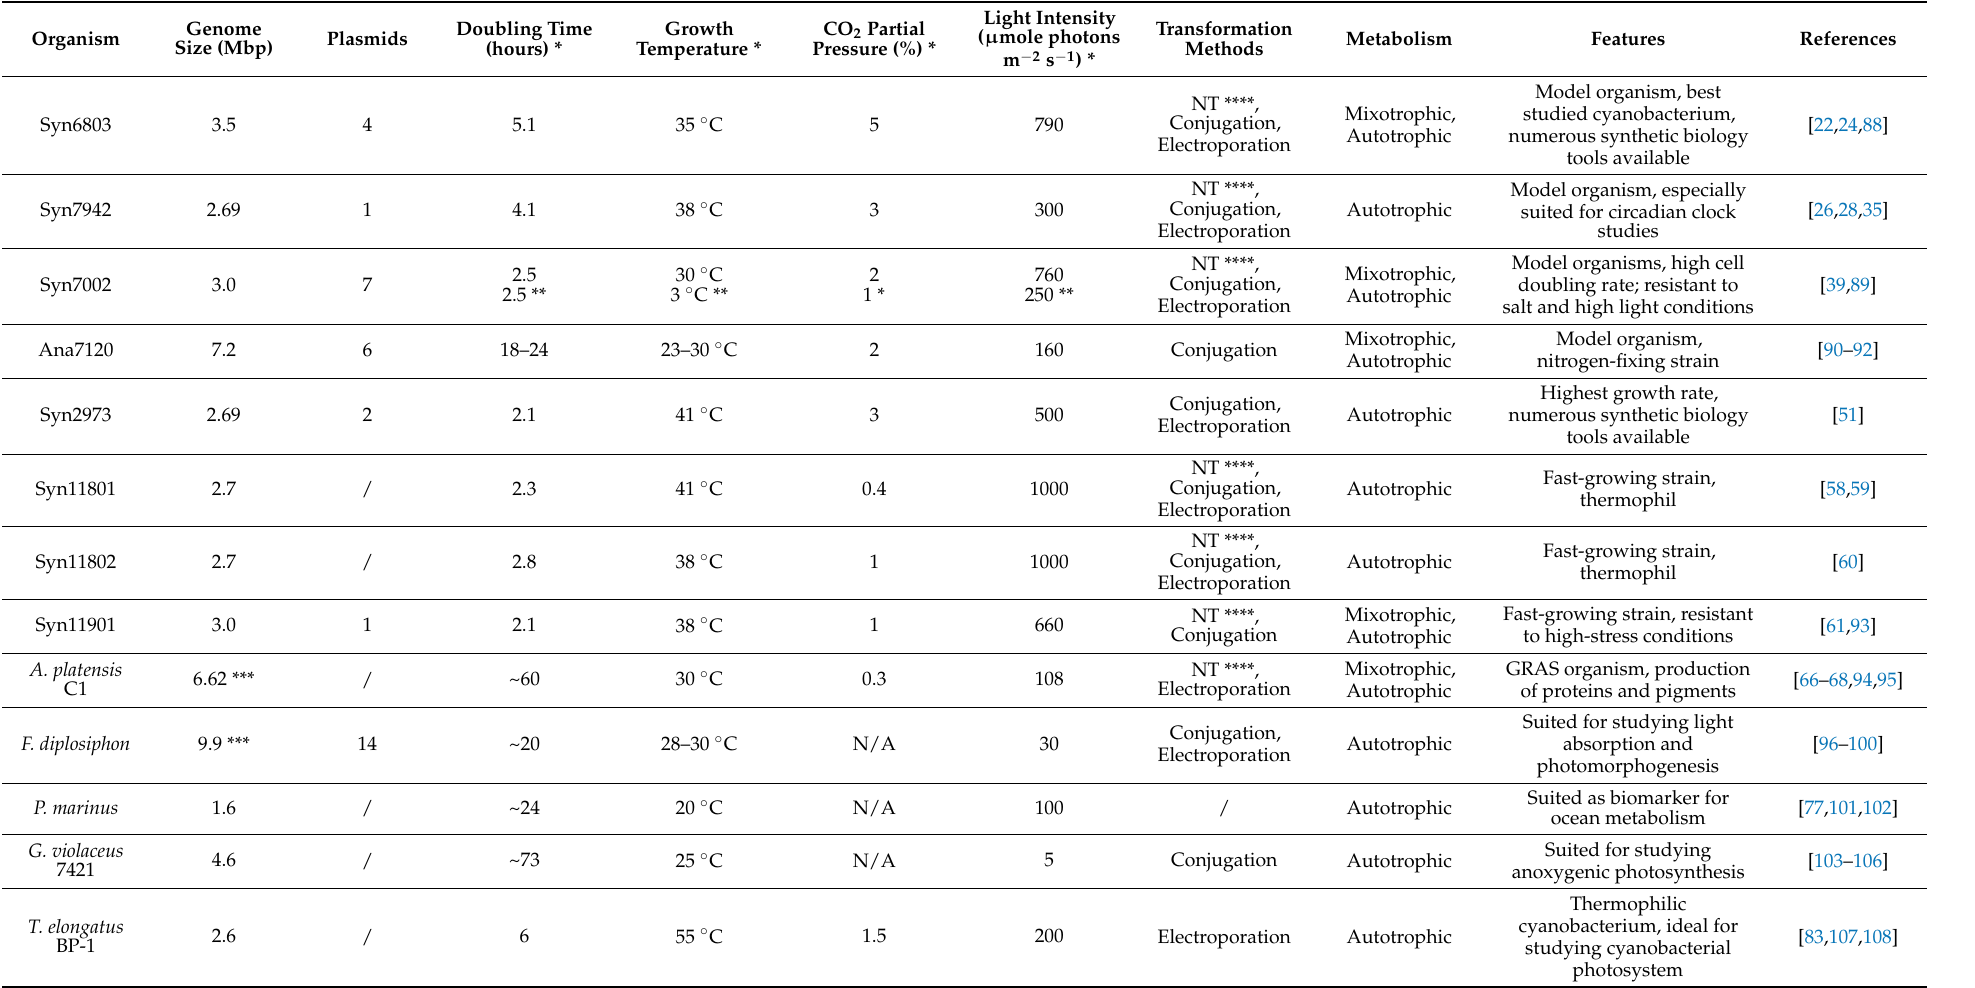
Table 1. Main features of cyanobacteria